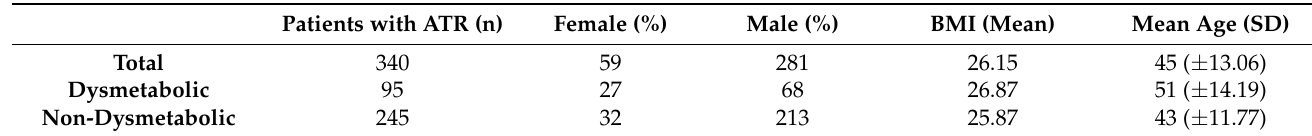
Table 2. Baseline demographic characteristics. Note: ATR = Achilles Tendon Rupture; BMI = Body Mass Index; SD = Standard Deviation.